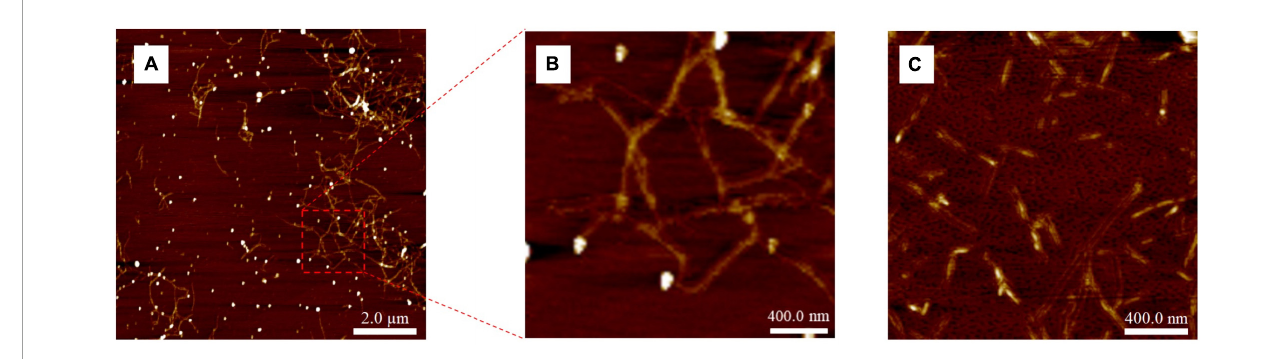
FIGURE4 AFM images of (A) Ac90 (10 µ m × 10 µ m), (B) enlarged area of Ac90, and (C) H15 (2 µ m × 2 µ m).